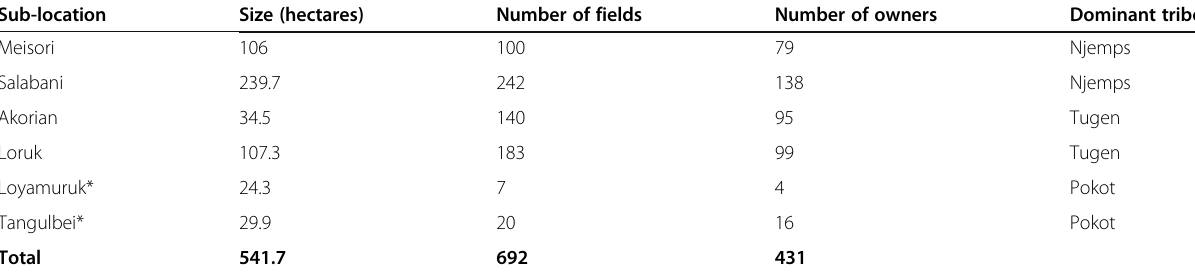
Table 1 Sub-locations, fields, and the three tribes Sub-location